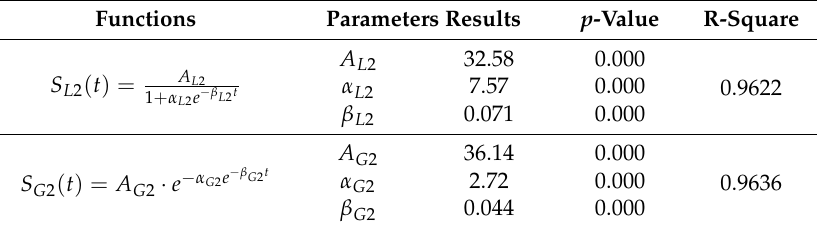
Table 3. The regression results about the parameters of seed production of Pistacia chinensis . Functions